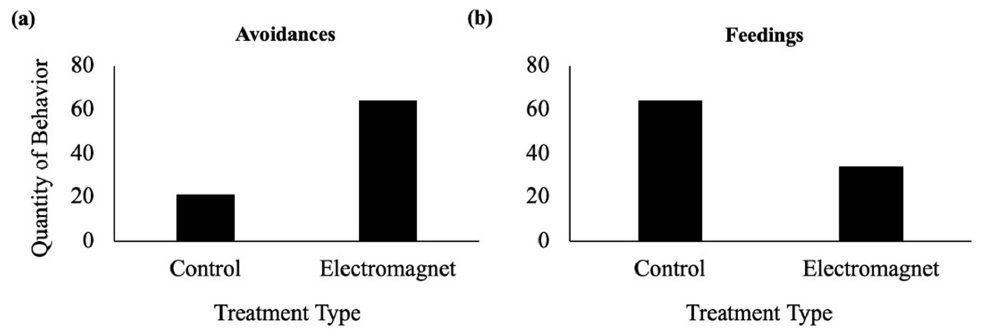
Figure 5. The total quantity of bull shark ( Carcharhinus leucas ) behaviors towards the inactivated electromagnet (i.e., control) and the activated electromagnet during the bait experiment. ( a ) Avoid- ance behaviors and ( b ) feeding